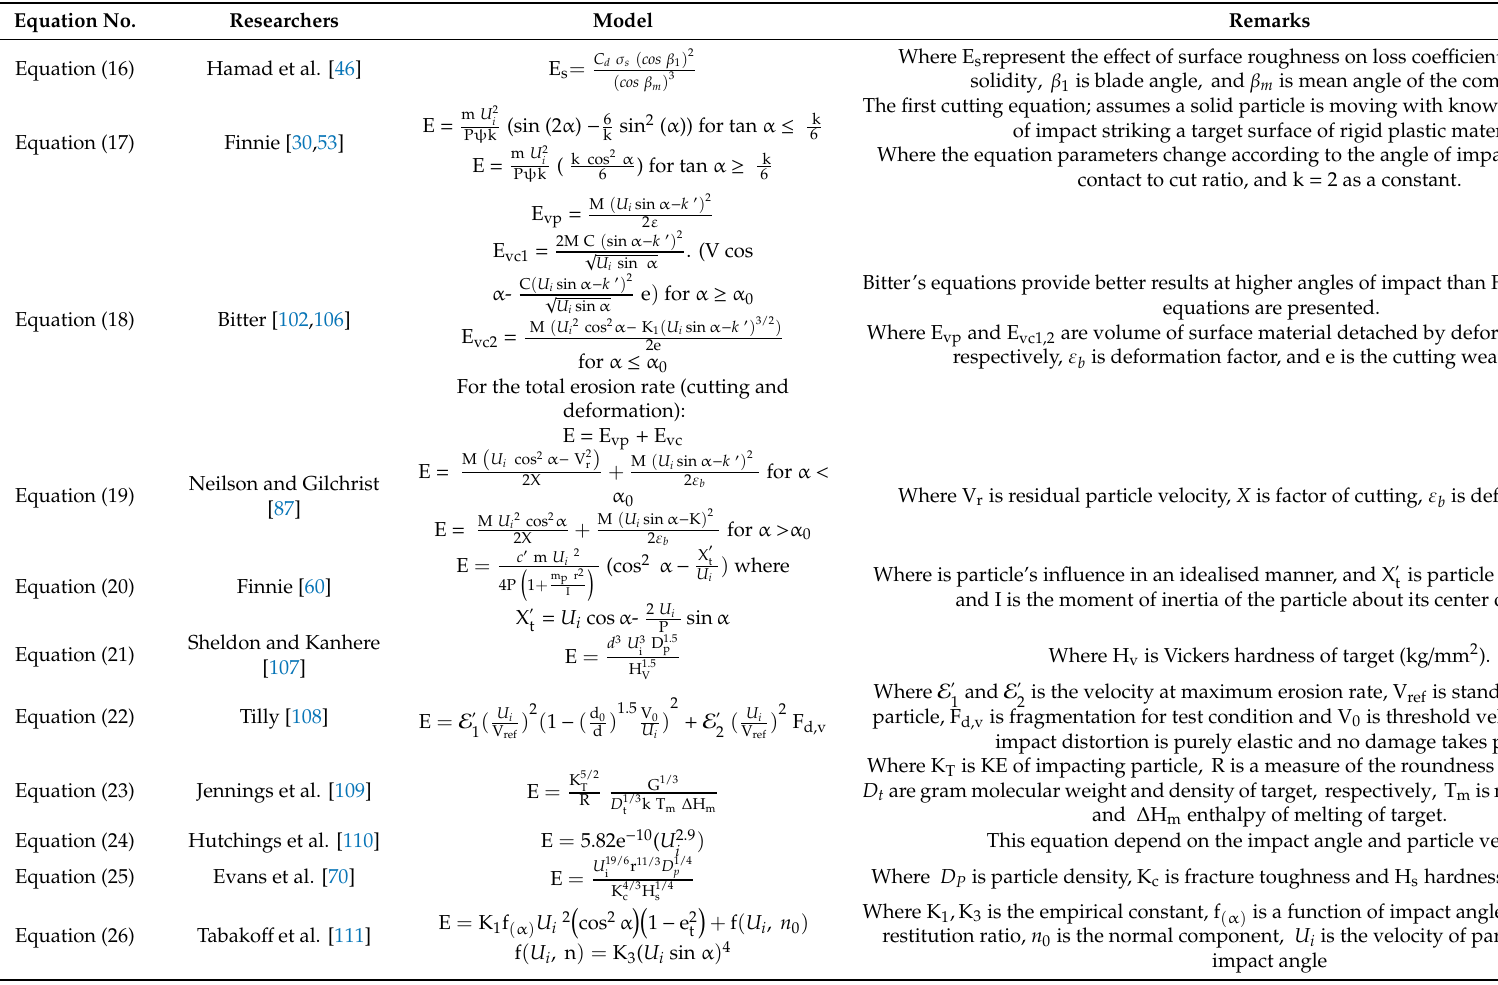
Table 3. Key SPE equations available in the